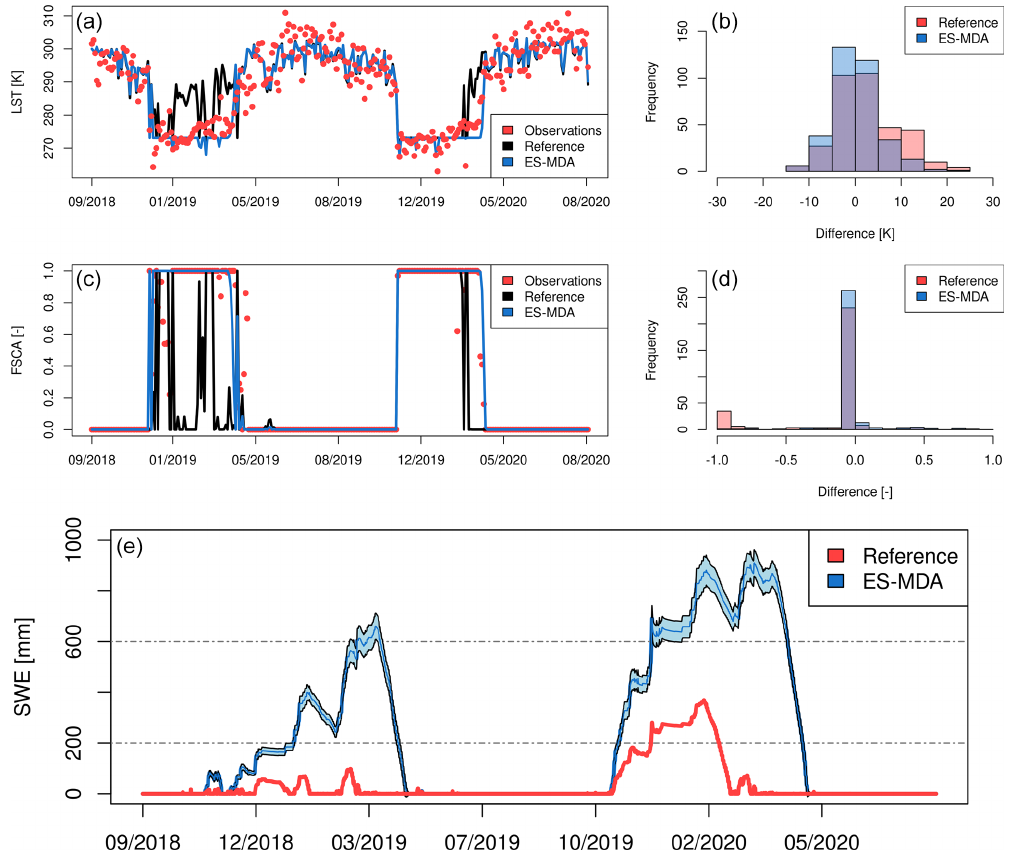
Figure 7. Joint LST (a, b) and FSCA (c, d) data assimilation and its influence on the SWE simulations (e)